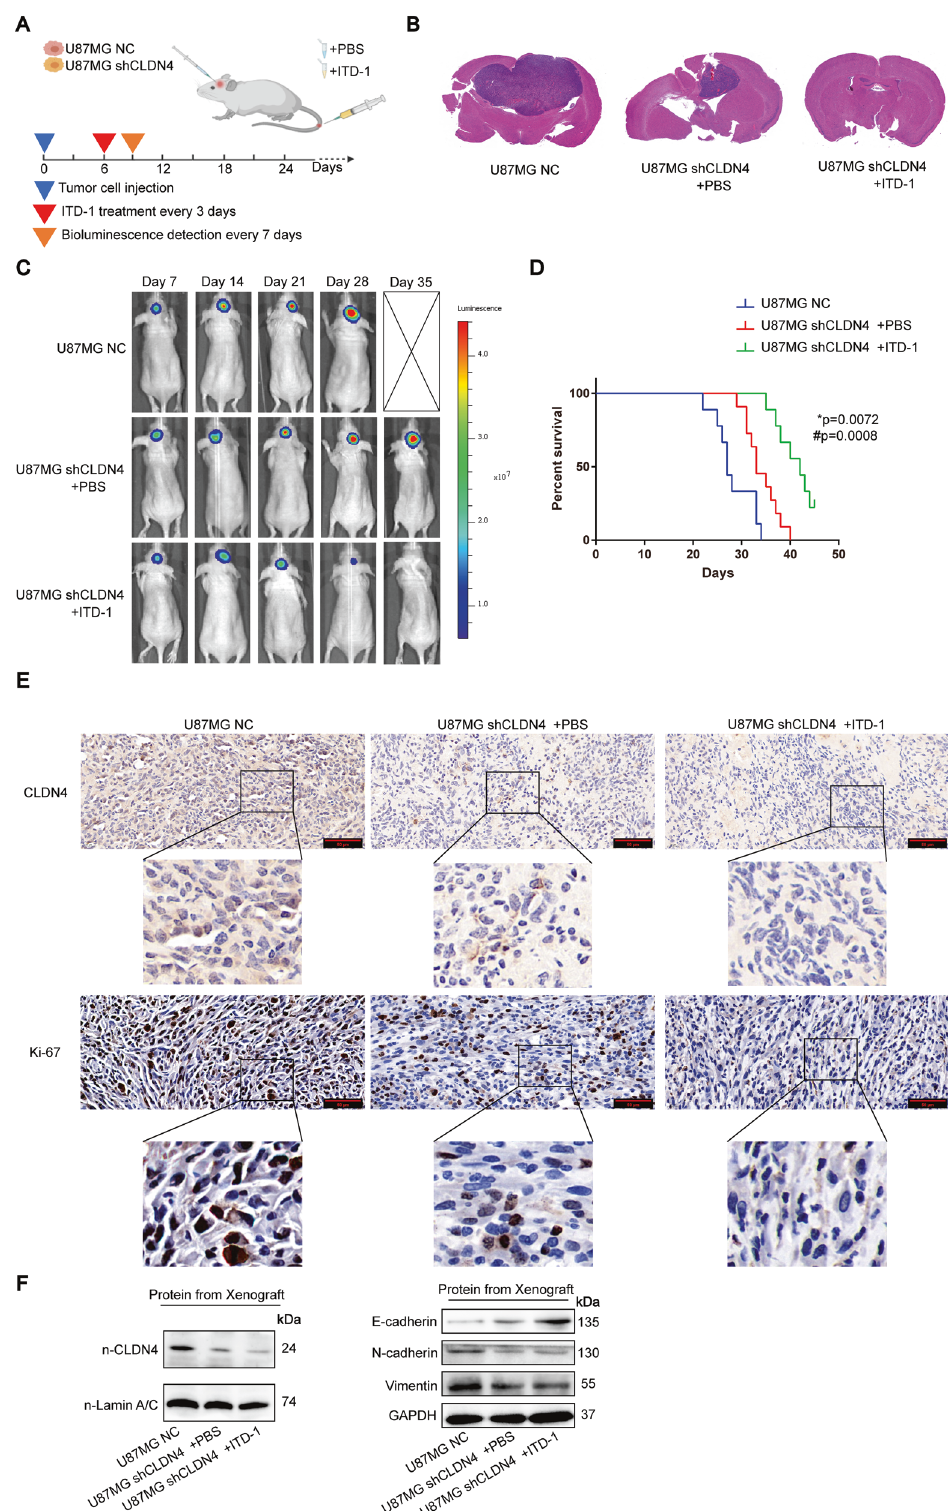
TGF β 1 upregulates CLDN4 in GBM cells Further exploration of the upstream signal pathway of CLDN4 is crucial for the treatment of GBM. In the colon, classical TGF β signal pathway regulates the expression of the connexin CLDN4 [16].